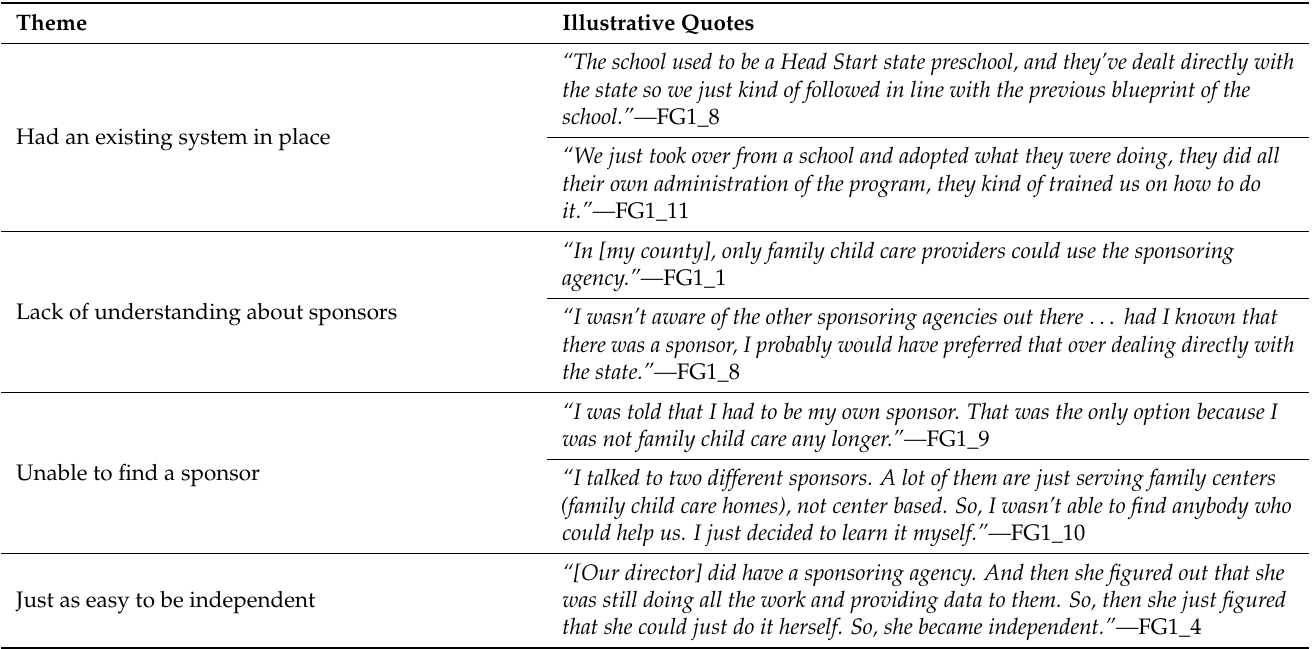
Table 7. Emergent themes of reasons independent centers do not work with a CACFP sponsoring organization 1